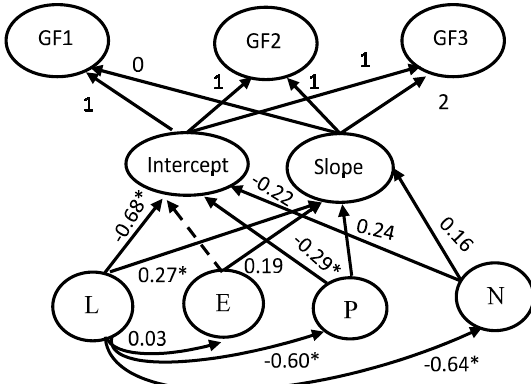
Figure 3. The growth model of Gf with personality effect on Gf intercept and slope. Note: See the full model in Supplementary Materials (Study 1, Model 2) presenting model codes and complete